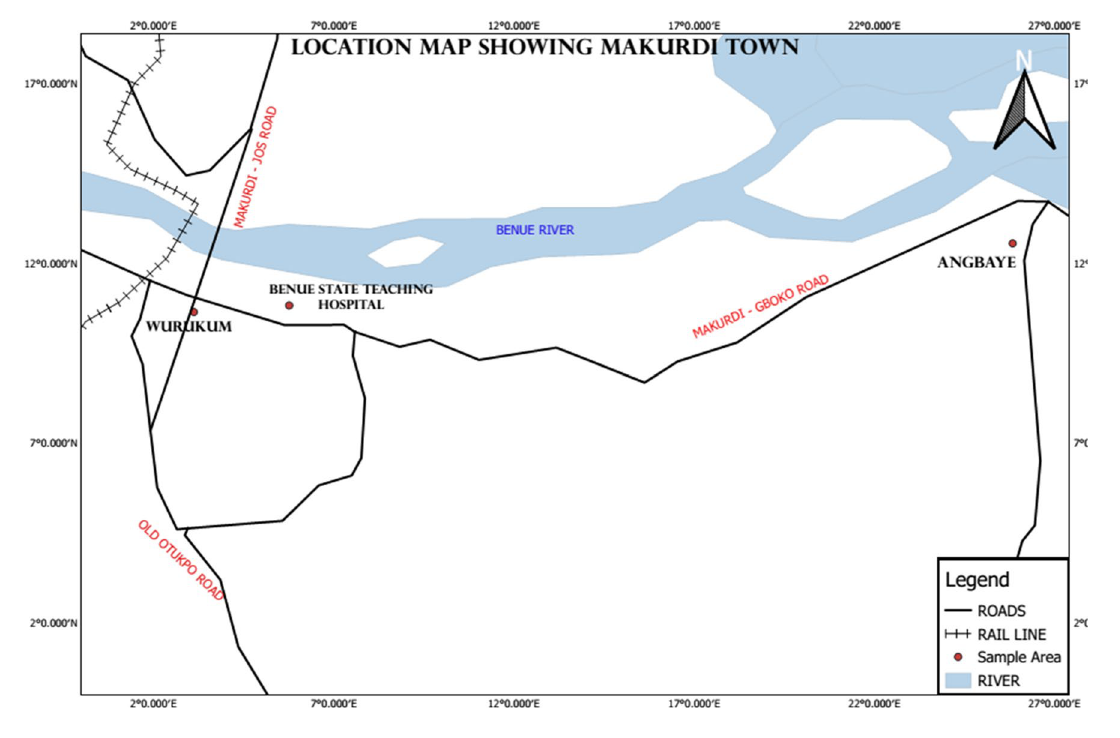
Fig. 2 Map of Makurdi showing River Benue and the sampling points Table 1 Location of sampling points Sampling station